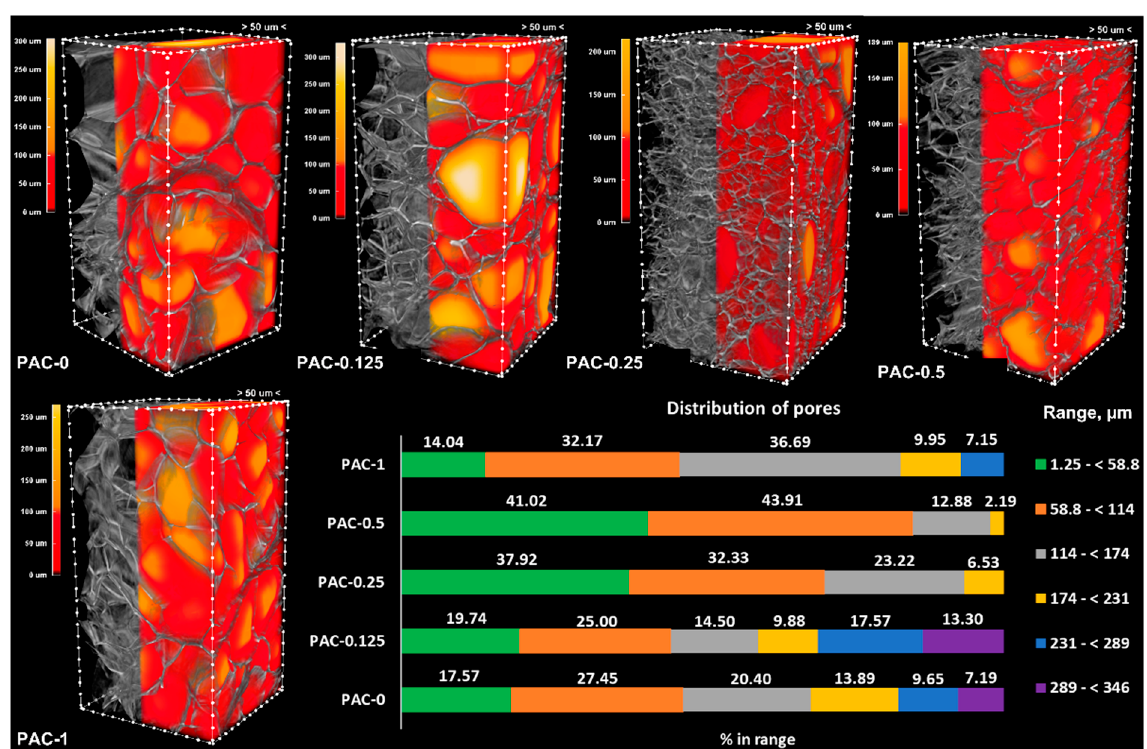
Figure 4. Three-dimensional images of the PAC samples and graphical representation of the poros- ity measurements.